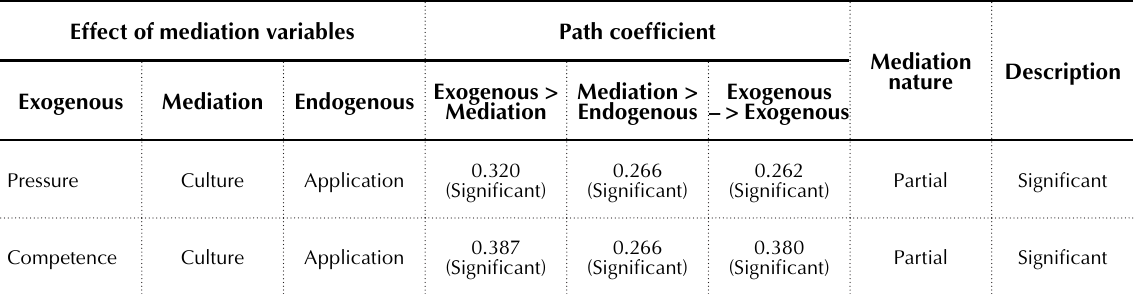
Table 2. Results of the mediation variable effect